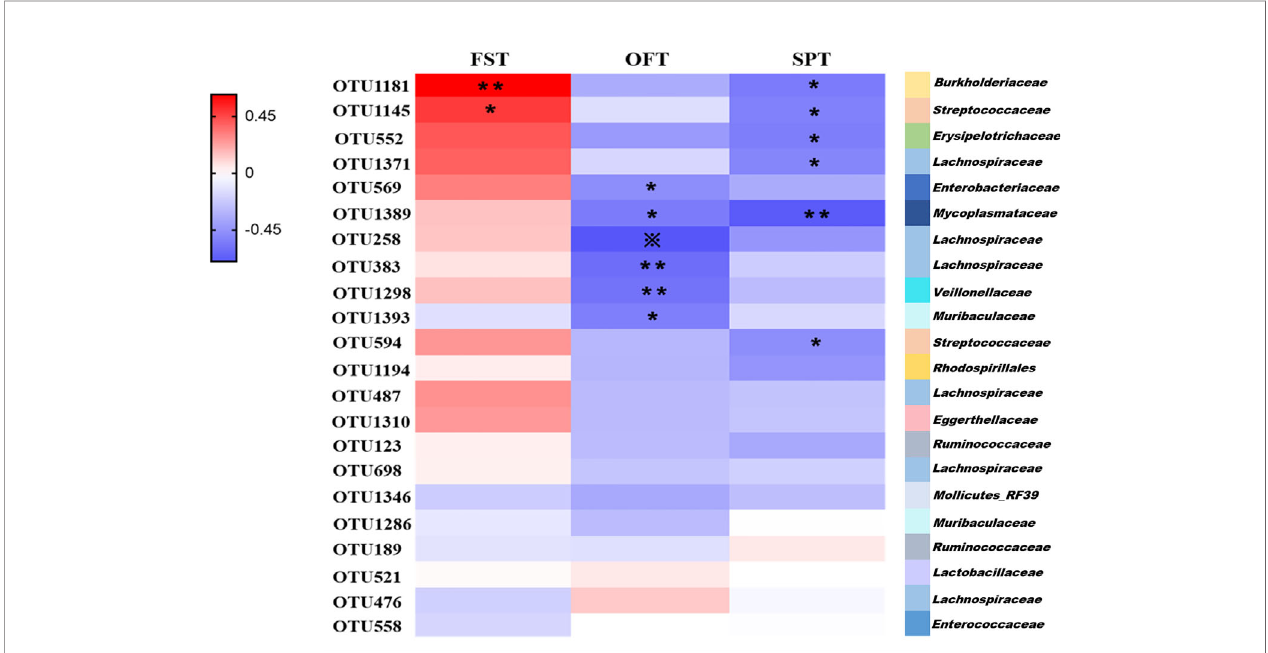
FIGURE 5 | Associations of altered gut microbes with behavior indices. Heat map of the Spearman ’ s rank correlation coef fi cient of 22 discriminative OTUs for PSD and 3 behavior indices. Red rectangle indicates positive associations between these microbial species and behavior indices, blue rectangle indicates negative associations (n = 6 per group). Overall, 22 discriminative OTUs for PSD were positively associated with FST, and negatively associated with SPT and OFT. 11 of 22 differential microbial variances (50%) were signi fi cantly associated with 3 behavior indices (p value < 0.05) and correlation coef fi cient were ≥ 0.45 or ≤ − 0.45, tested by spearman correlation. The statistical signi fi cance was denoted on the rectangle (*p < 0.05; **p < 0.01; ※ p <